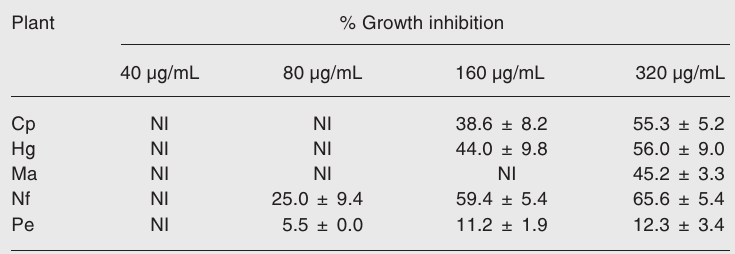
NI = not inhibited.